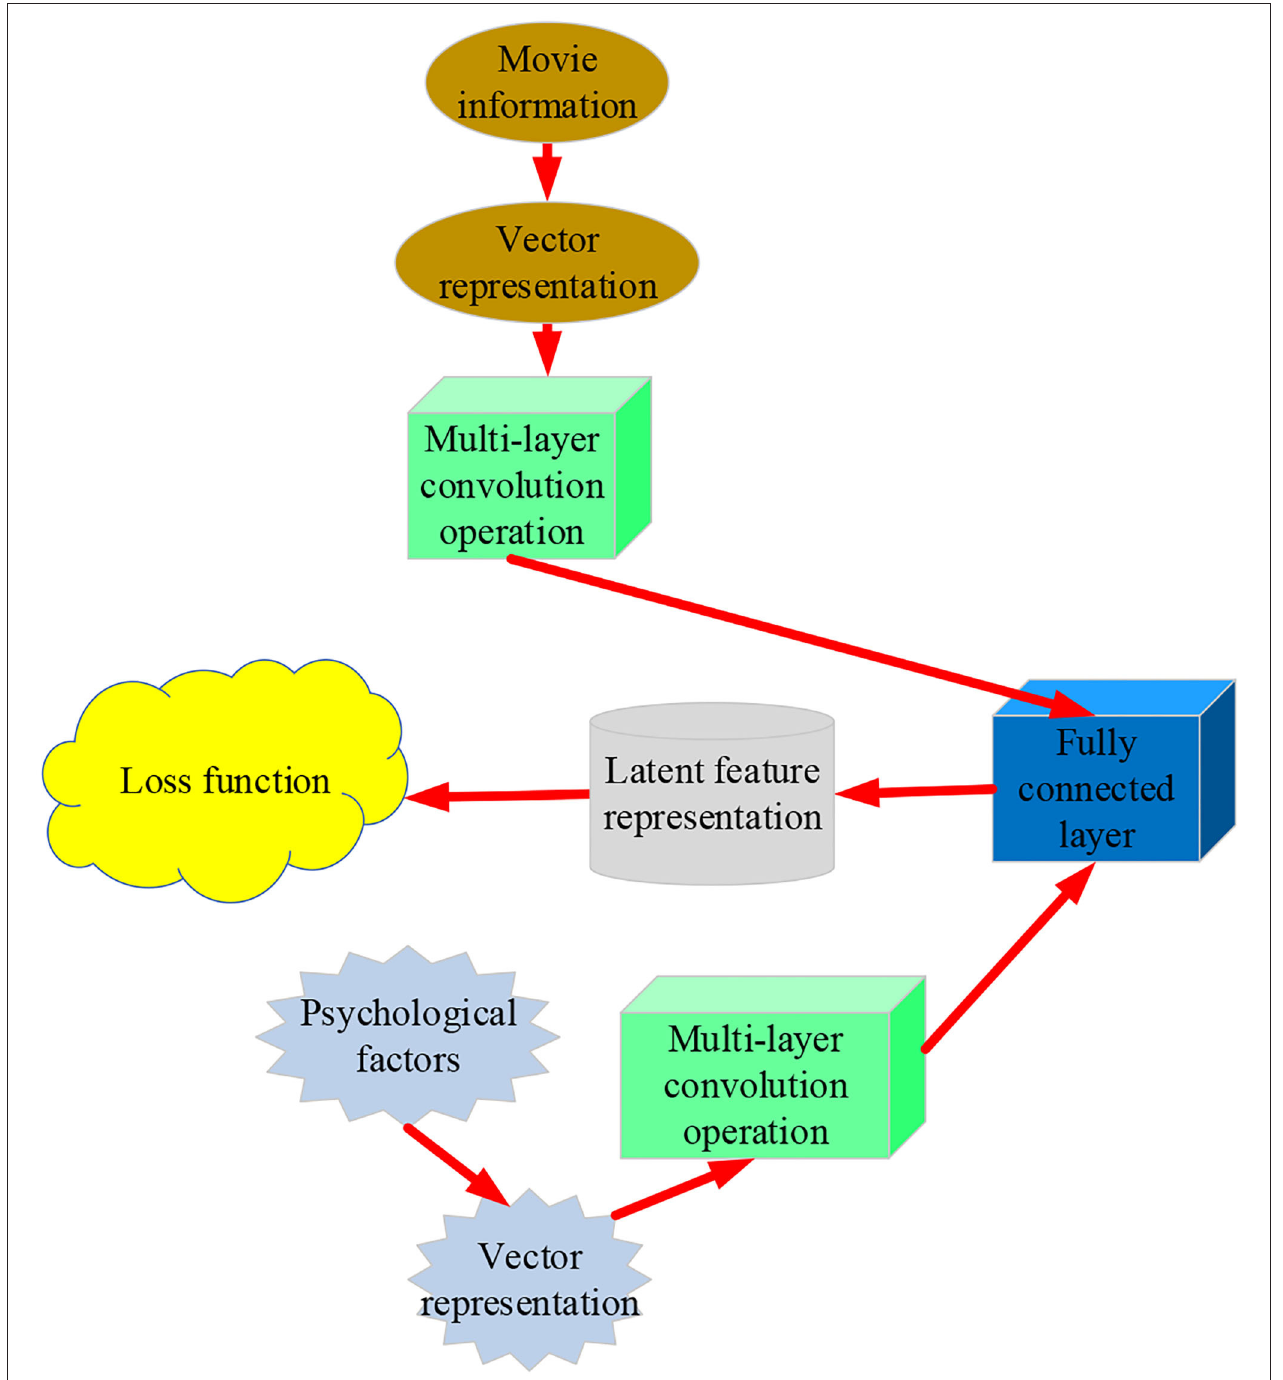
FIGURE 3 | Framework of the